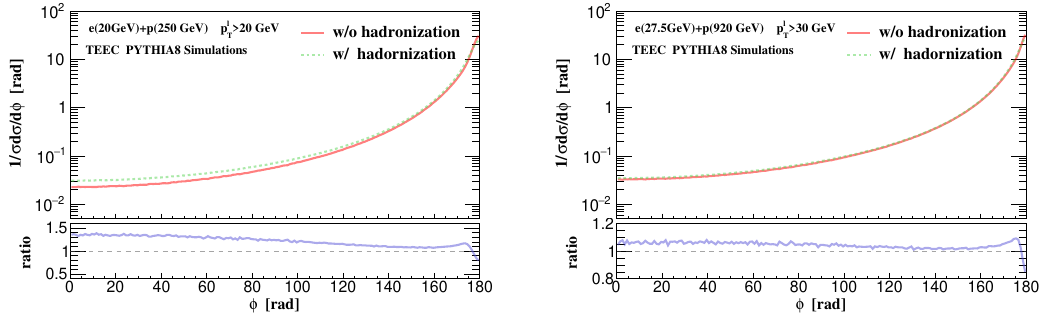
Figure 1 . Pythia simulations of the TEEC distribution versus φ with and without hadronization √ effects. We consider center-of-mass energy s = 141 GeV with p l > 20 GeV (left), and enter-of- T √ mass energy s = 318 GeV with p l > 30 GeV (right). The ratio is defined as predictions with T hadronization effects divided by the ones without hadronization